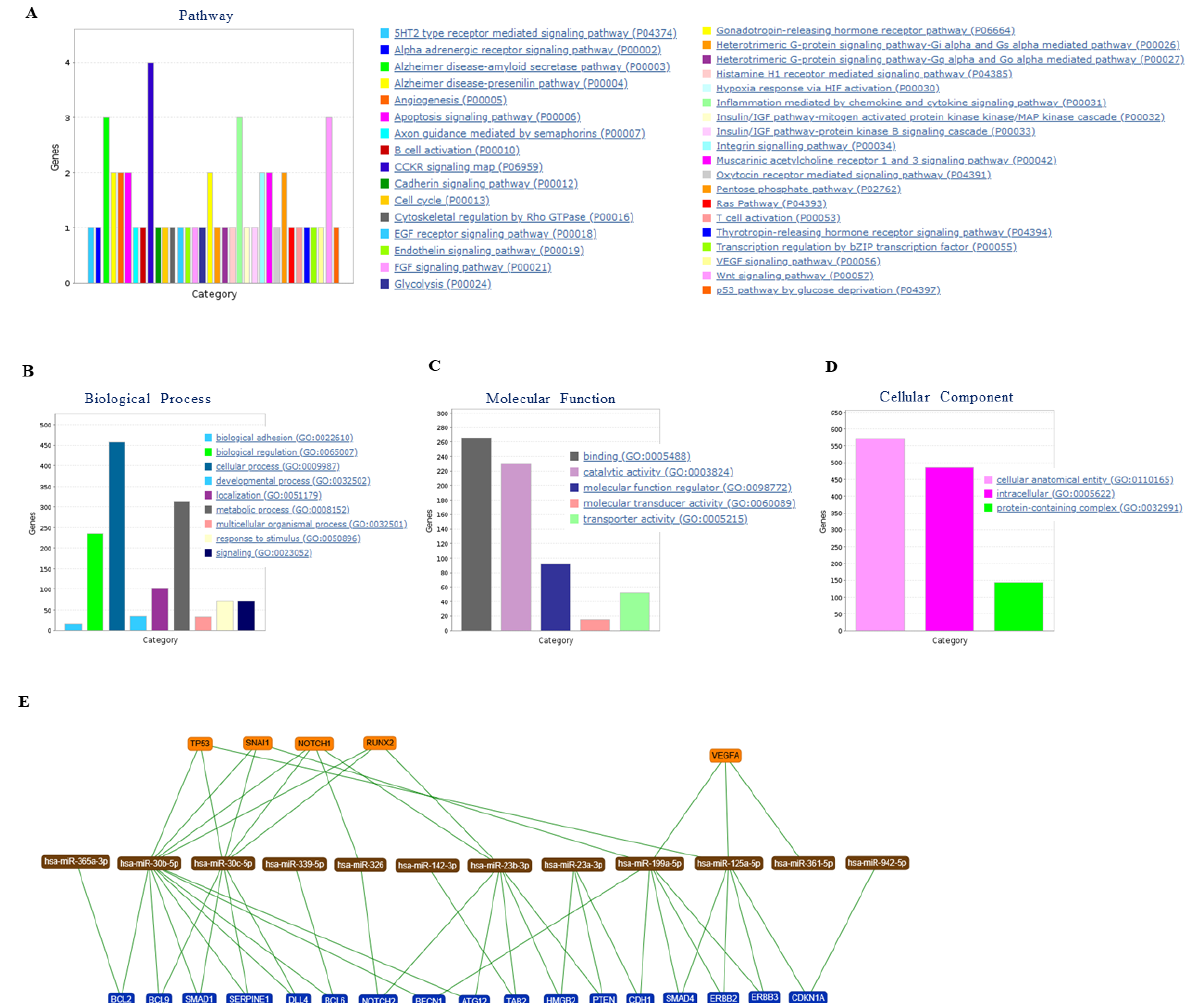
Figure 5. Pathways, Gene Ontology, and network enrichment analyses by using PANTHER and miRTargetLink tools for the identified protein-coding genes through mRNA microarray. Distribution of genes according to the ( A ) KEGG pathways, ( B ) biological process, ( C ) molecular function, ( D ) type of cellular component, and ( E ) network of the identified miRNAs, which have a binding site within the 3 (cid:48) UTR of the identified target mRNAs. MiRNAs are shown as brown nodes, genes targeted by at two miRNAs as blue, and genes targeted by at least three miRNAs as orange